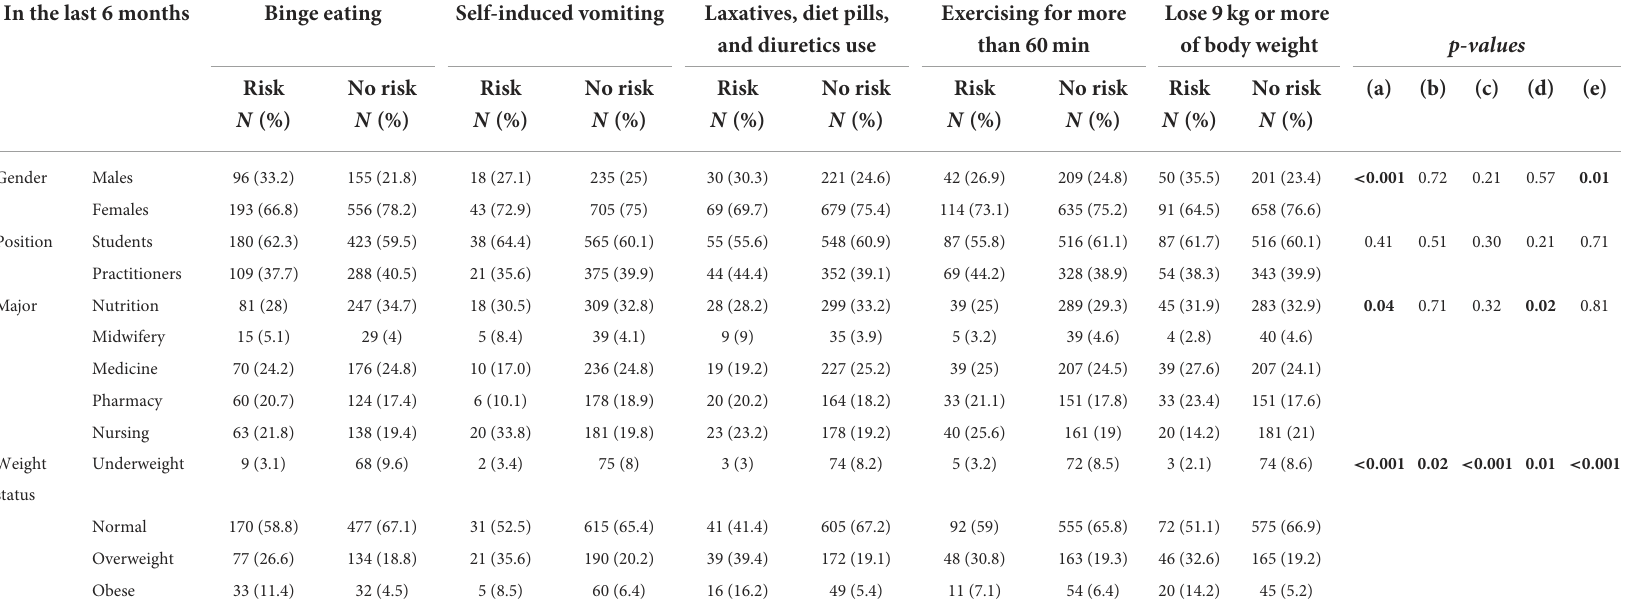
(a)Thelevelofsignificancerelatedtobingeeating. (b)Thelevelofsignificancerelatedtoself-inducedvomiting. (c)Thelevelofsignificancerelatedtolaxatives,dietpills,anddiureticsuse. (d)Thelevelofsignificancerelatedtoexercisingformorethan60min. (e)Thelevelofsignificancerelatedtolosing9kgormoreofbodyweight.Boldvaluesmeansignificantat p <